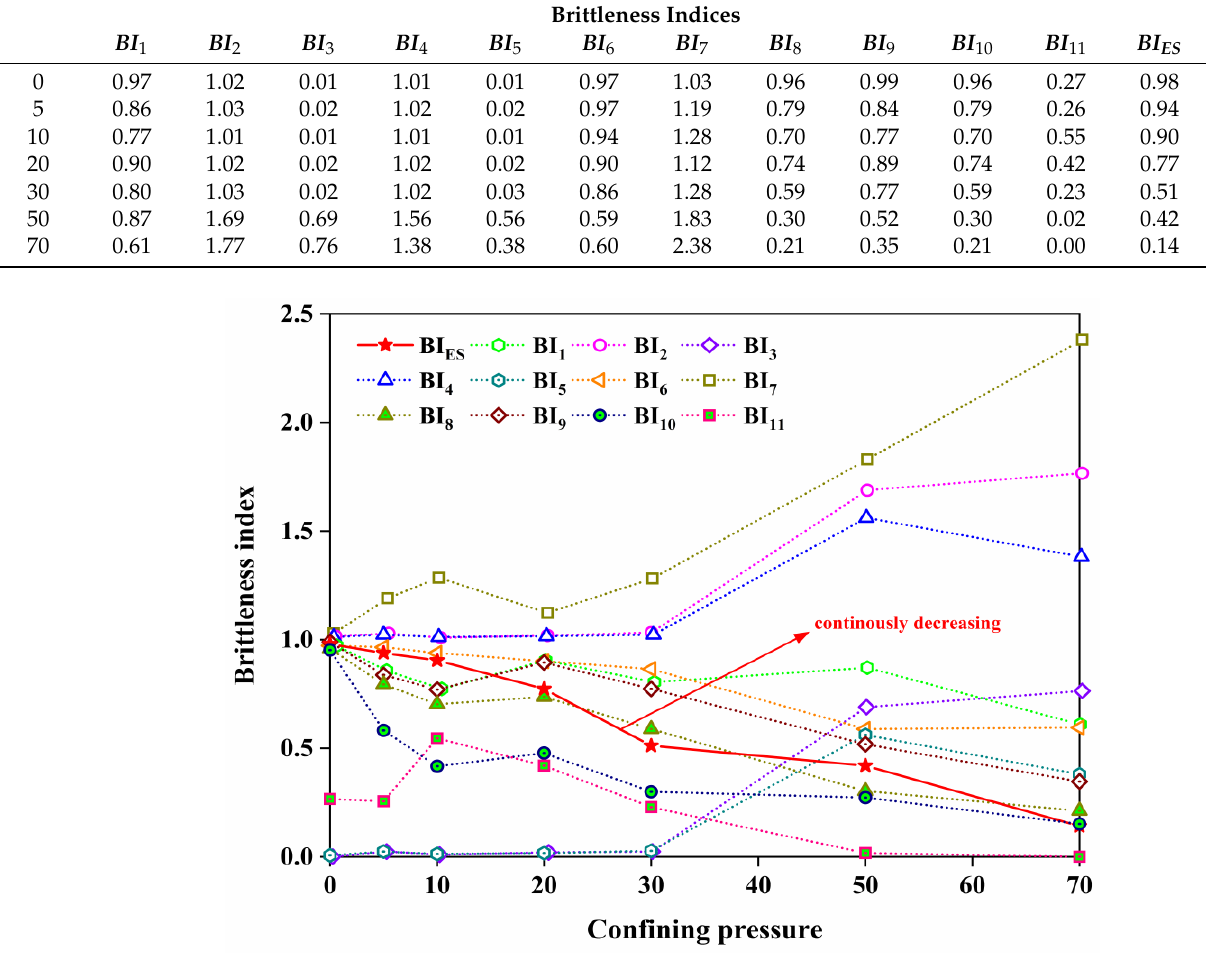
Figure 9. Comparison of BI ES with existing energy-based brittleness indices based on the shale samples in the CTC tests.